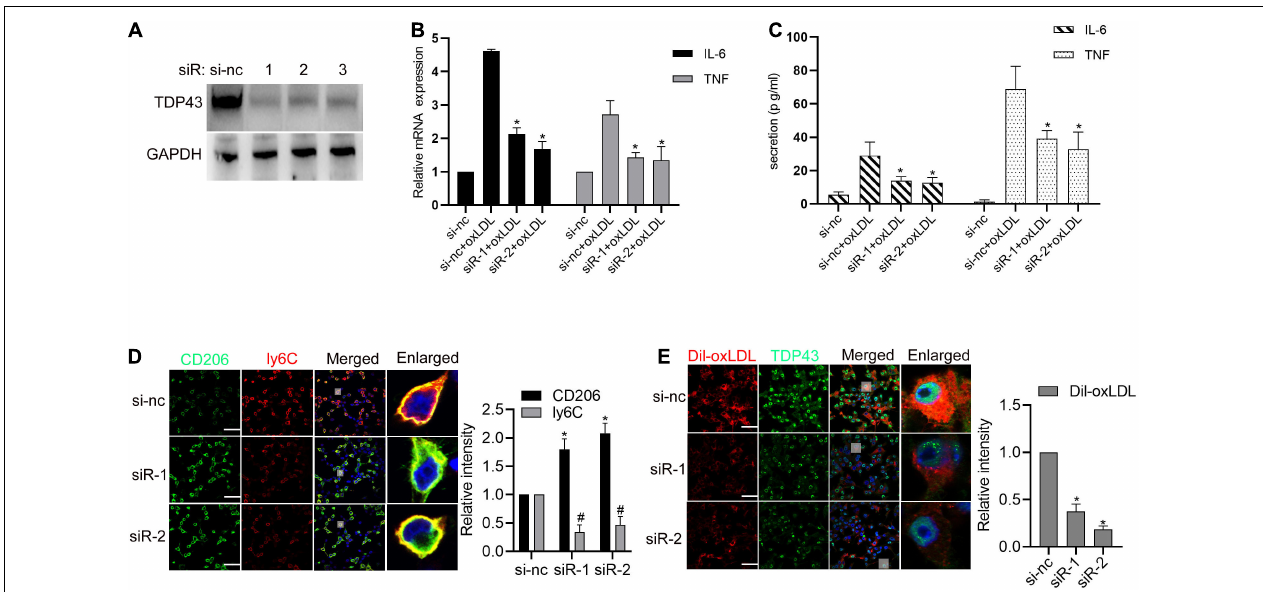
FIGURE 2 | Transactive response DNA-binding protein ∼ 43 kDa (TDP43) promotes oxLDL-induced inflammation and foam cell formation in macrophages. (A) Western blot analysis of TDP43 expression in macrophages transfected with TDP43 specific siRNA ( − 1, − 2, − 3) or a non-specific negative control siRNA (si-nc) for 24 h. GAPDH was used as a loading control. (B) qPCR detection of IL-6 and TNF mRNAs in macrophages transfected with TDP43 specific siRNA (siR-1, siR-2) or si-nc for 24 h and later incubated with 40 µ g/mL oxLDL for 24 h. Data are represented as means ± SD ( n = 3; * P < 0.05 vs. si-nc + oxLDL group). (C) ELISA detection of IL-6 and TNF expressions in the culture supernatants of macrophages transfected with TDP43 specific siRNA (siR-1, siR-2) or si-nc for 24 h and later incubated with 40 µ g/mL oxLDL for 24 h. Data are represented as means ± SD ( n = 3; * P < 0.05 vs. si-nc + oxLDL group). (D) Immunofluorescence analysis of CD206 and ly6C expression in macrophages transfected with TDP43 specific siRNA ( − 1, − 2) or si-nc for 24 h. Data are represented as means ± SD ( n = 50; * or # P < 0.05 vs. si-nc group). Scale bar = 100 µ m. (E) Immunofluorescence analysis of Dil-oxLDL uptake of macrophages transfected with TDP43 specific siRNA ( − 1, − 2) or si-nc for 24 h. Data are represented as means ± SD ( n = 50; * or # P < 0.05 vs. si-nc group). Scale bar = 100 µ